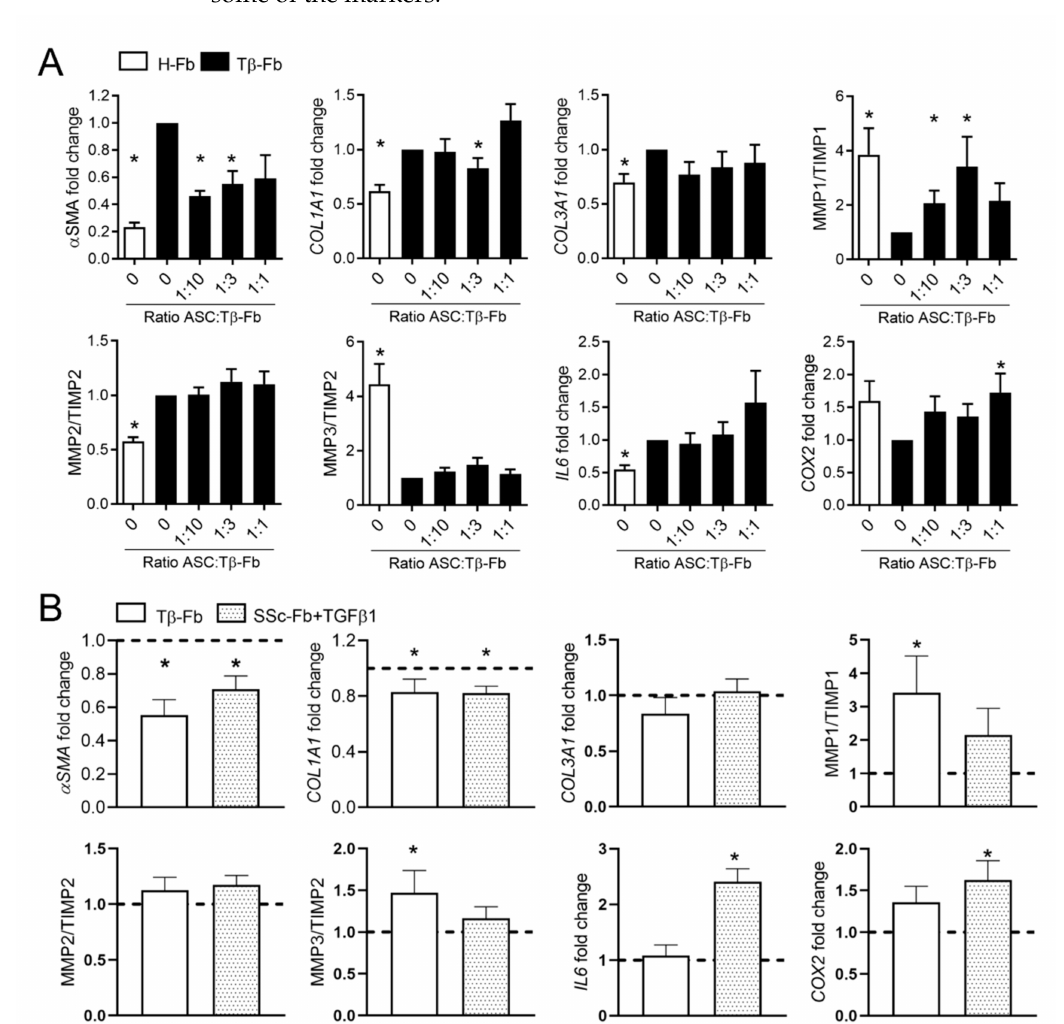
Figure 4. Effect of adipose tissue-derived mesenchymal stromal cells (ASCs) on TGF β 1-stimulated fibroblasts. ( A ) Fold change of gene expression in healthy fibroblasts (H-Fb) and TGF β 1-stimulated fibroblasts (T β -Fb) normalized to H-Fb ( n = 14). ( B ) Fold change of gene expression of markers as in ( A ) in T β -Fb or TGF β 1-stimulated SSc-Fb ( n = 8–14). *: p <